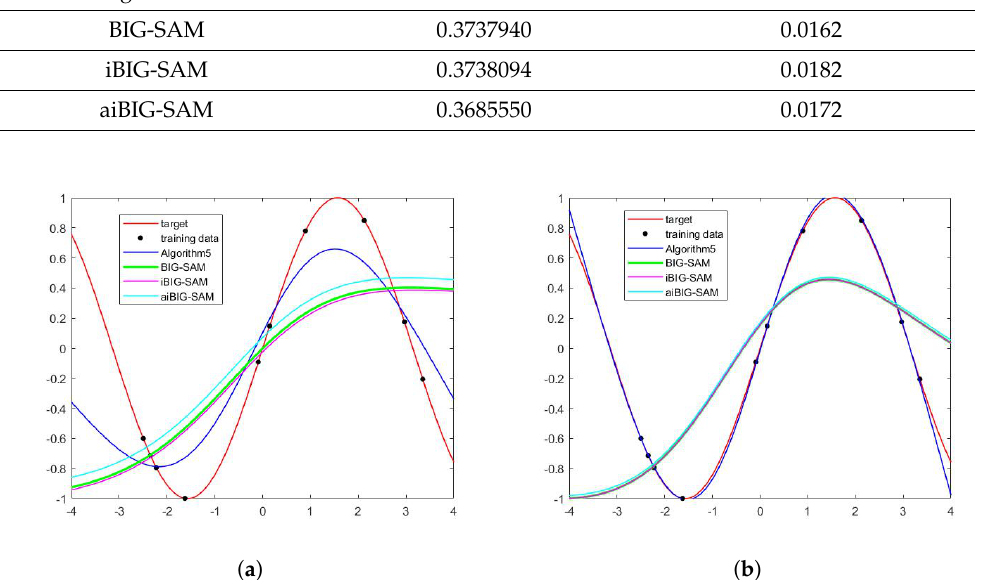
Figure 1. ( a ) A regression of the sine function at 100th step; ( b ) A regression of the sine function at 500th step.